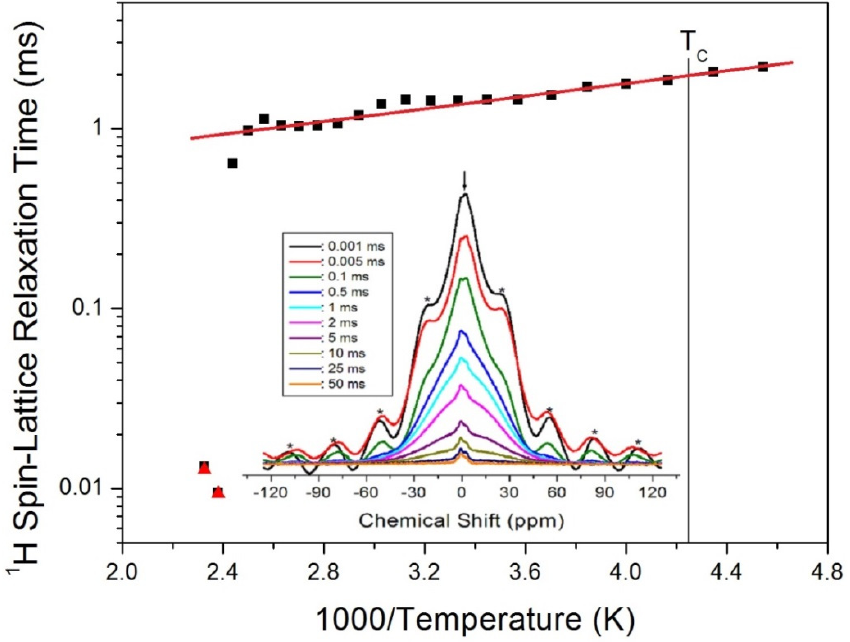
Figure 4. 1 H spin-lattice relaxation times T 1 ρ in the rotating frame in C 2 H 5 NH 3 cation of